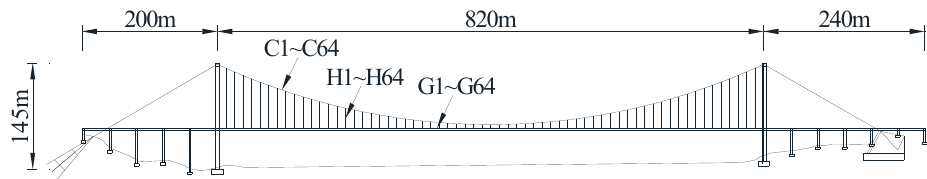
Figure 6. General arrangement and serial number of components of the Nanxi Yangtze River Bridge.